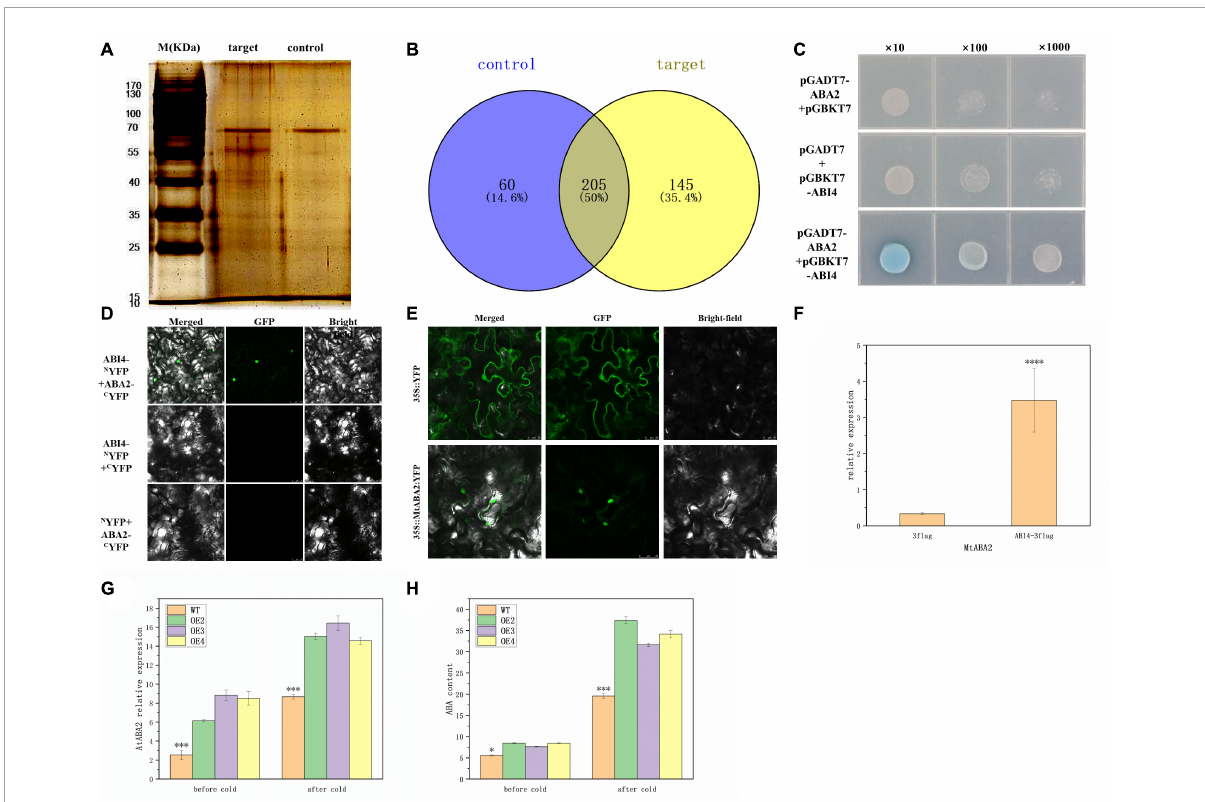
FIGURE6 IP-MS, Y2H, BIFC, the expression level of ABA2, and ABA content. (A) Represents the results of the SDS-page electrophoretic. (B) Represents the intersection of the target and control mass spectrometry data. (C) Represents the growth of yeast in the Y2H analysis. (D) Represents the fluorescence observed in the BIFC analysis. (E) Represents the subcellular location of ABA2. (F,G) Represent ABA2 expression levels in M. truncatula callus, and in transgenic Arabidopsis before and after low-temperature treatment. (H) Represents the ABA level in the plant before and after the low-temperature treatment. ∗ , in graphs, indicates significant differences in the means at p < 0.05 between each level in transgenic lines and WT plants, and ∗∗∗ , ∗∗∗∗ , in graphs, indicates significant differences in the means at p < 0.001 and p < 0.0001,